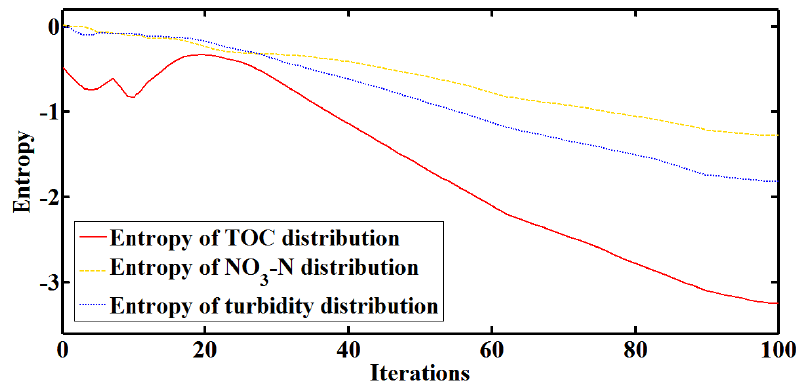
Figure 10. The entropy of water quality multi-parameter distribution during searching.